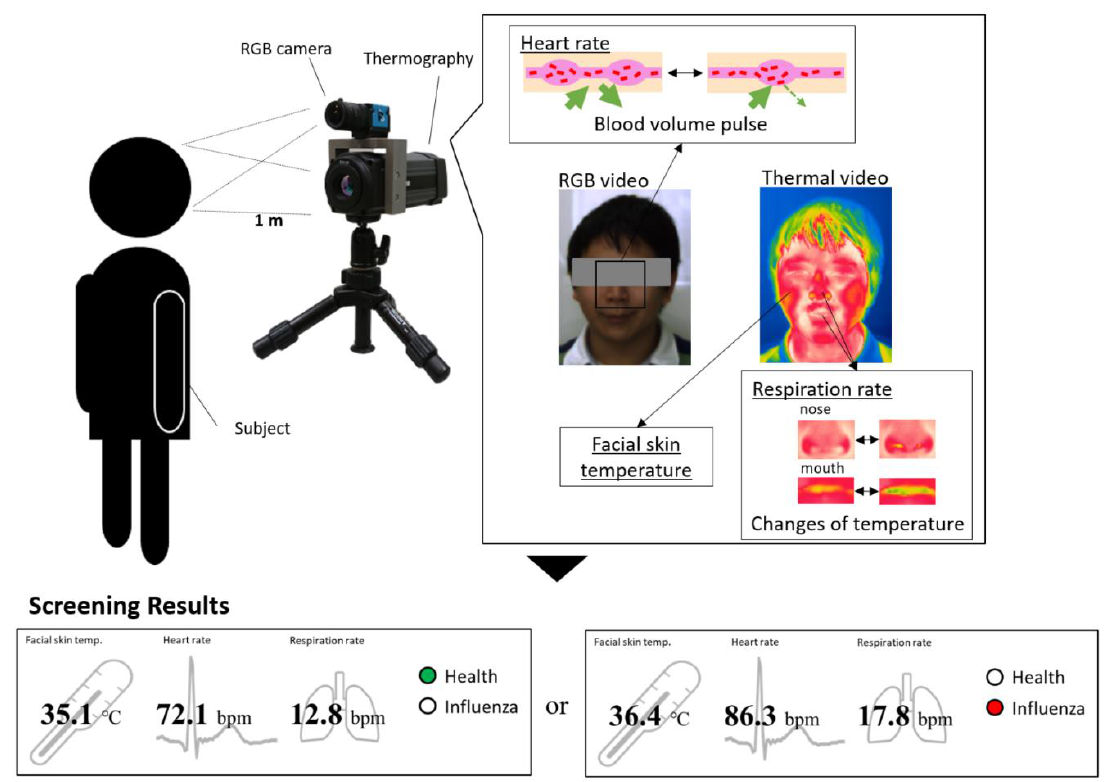
Figure 2. Overview of measurement principle that remotely senses multiple vital signs and an example of screening result.